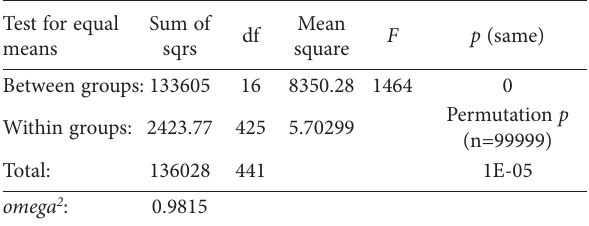
Table 4. One way ANOVA test results.